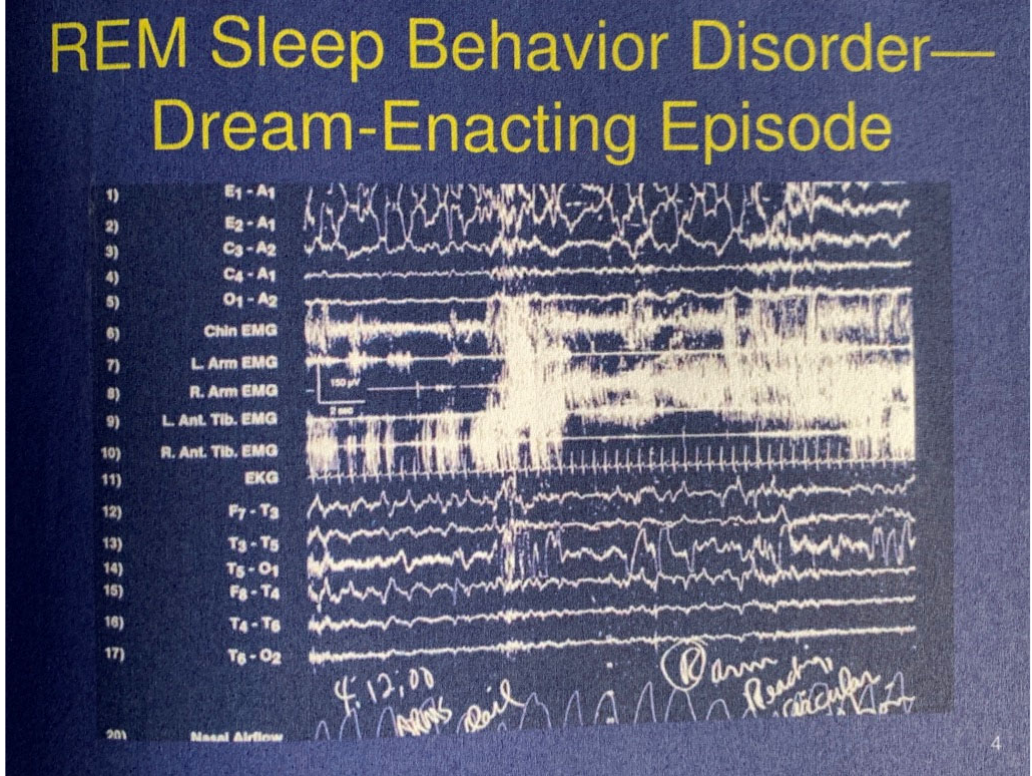
Figure 17. An episode of REM sleep behavior disorder (RBD). Note the intense rapid eye movements in the top 2 channels. The EMG channels show a loss of muscle tone at the start associated